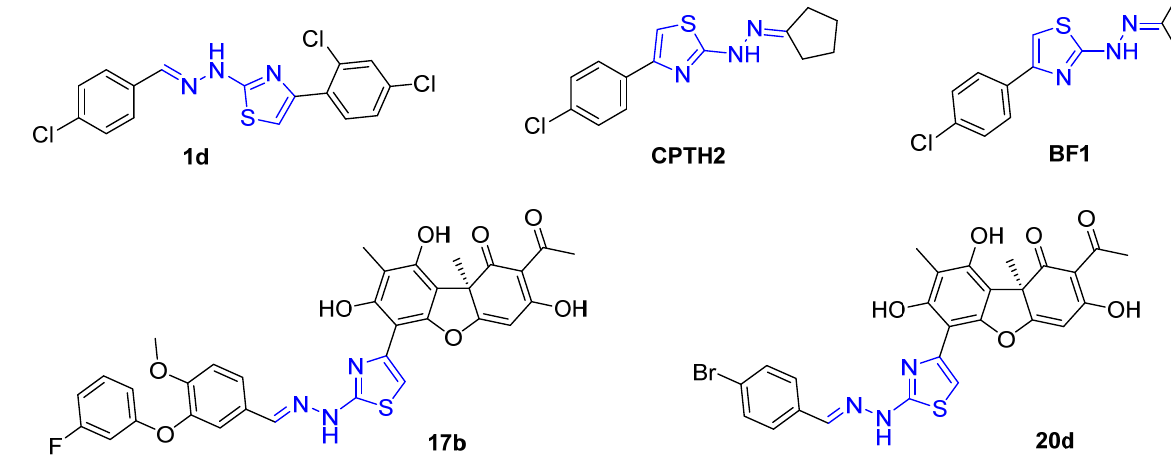
Figure 2. Selected structures of bioactive 2-(2-hydrazinyl)-1,3-thiazole compounds.